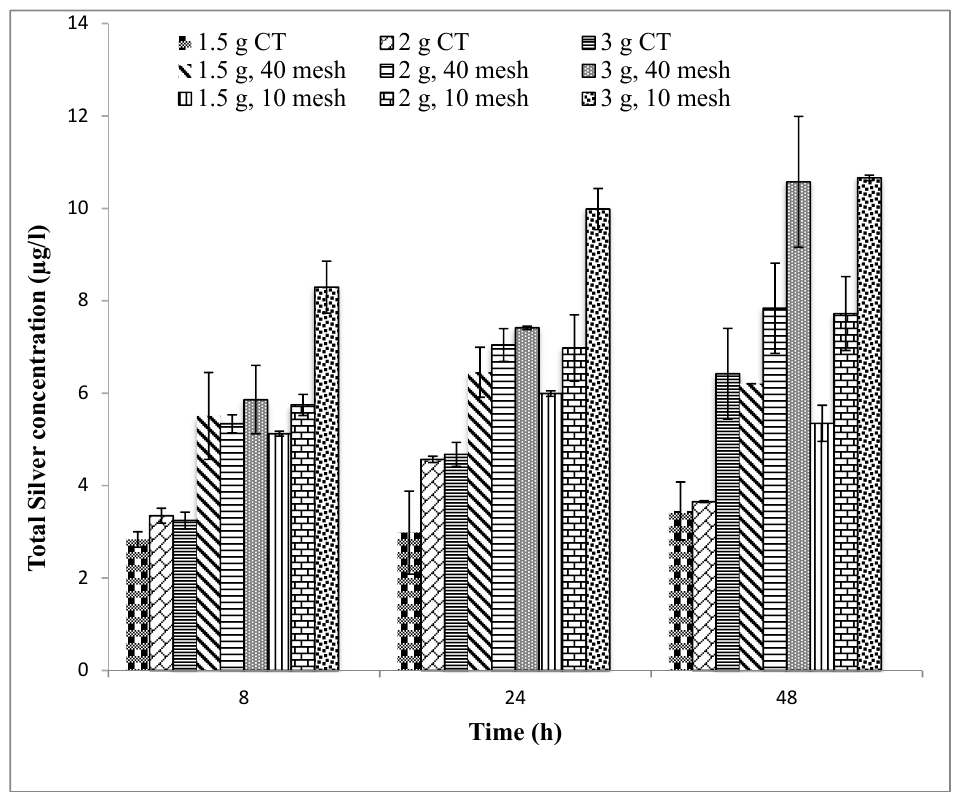
Figure 6. Total silver concentration of a single clay tablet containing 1 g of silver in 10 L of tap water after 8 and 24 h as a function of the particle size and density. Contained particles were held together in porous fabric pouches similar to standard tea bags. Dispersed particles were distributed evenly along the bottom of the container. An optimized solid clay tablet was made using the optimized firing protocol and compression pressure. Error bars represent standard error.